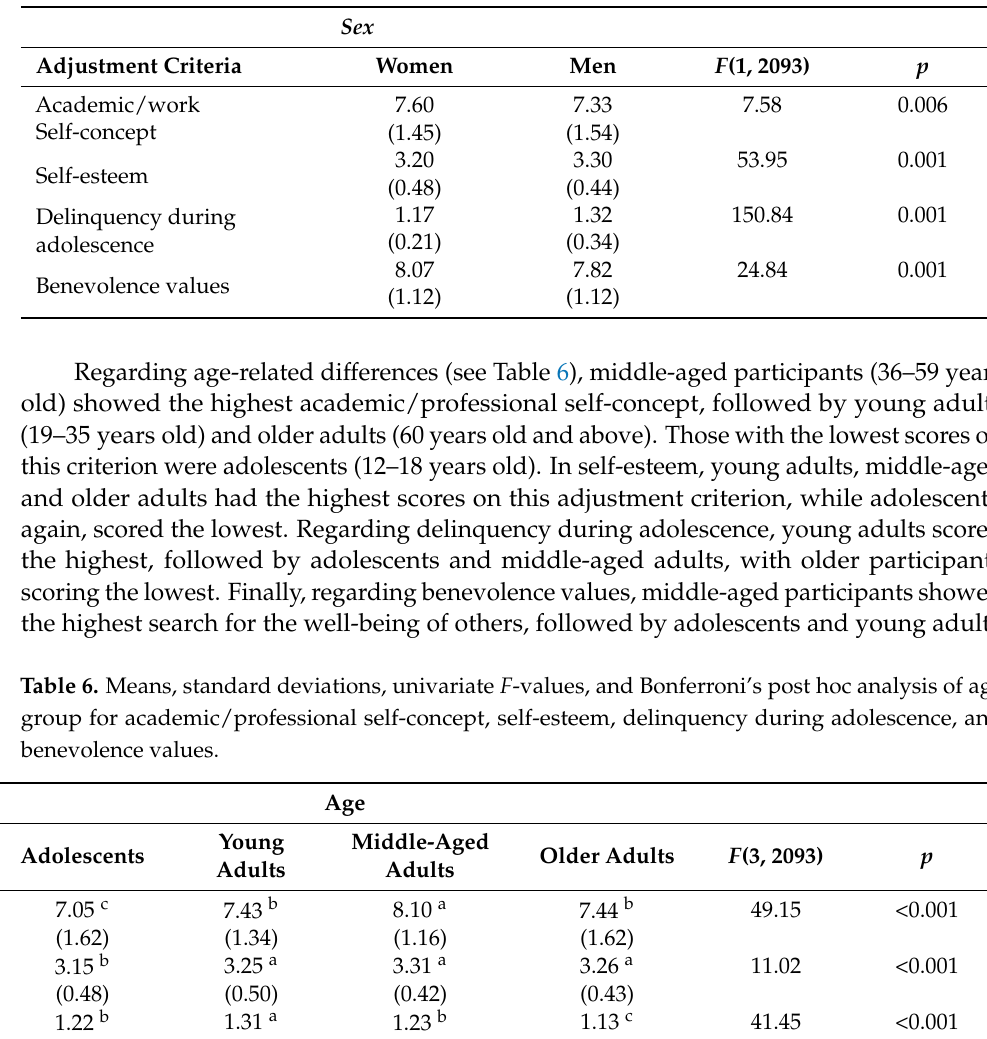
Table 5. Means, standard deviations, univariate F -values of sex for academic/professional self- concept, self-esteem, delinquency during adolescence, and benevolence values.